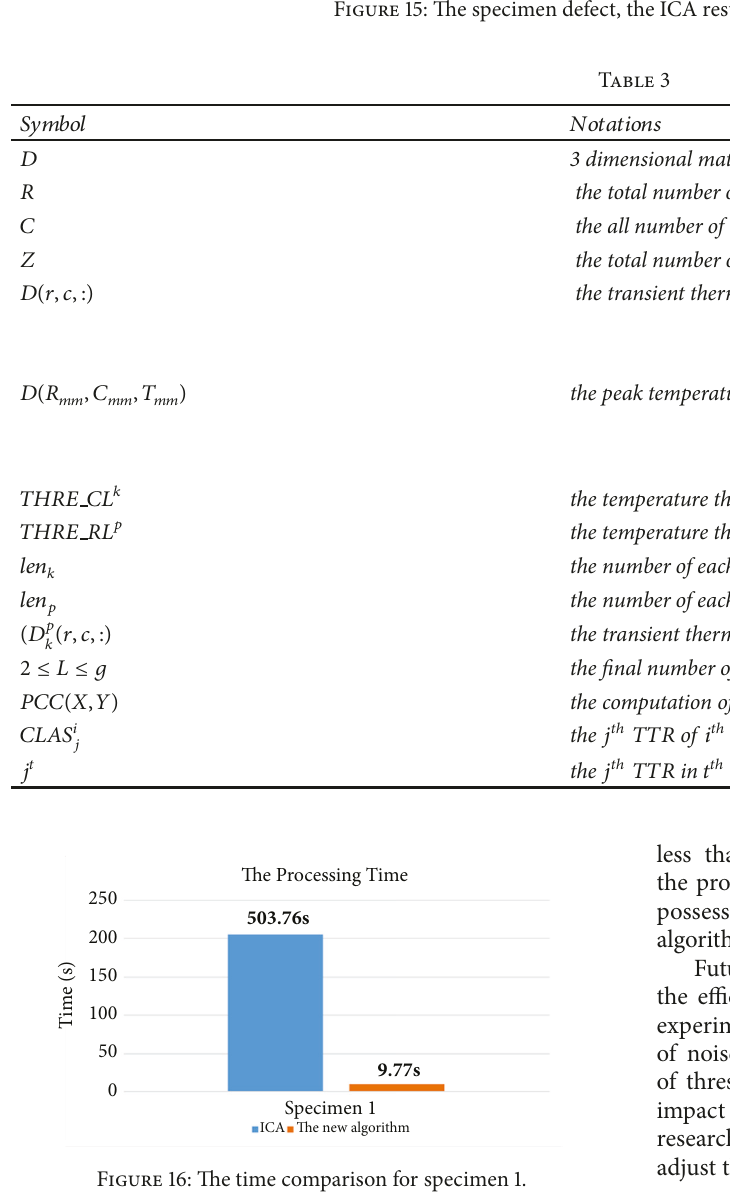
Figure 15: The specimen defect, the ICA result, and the final result.